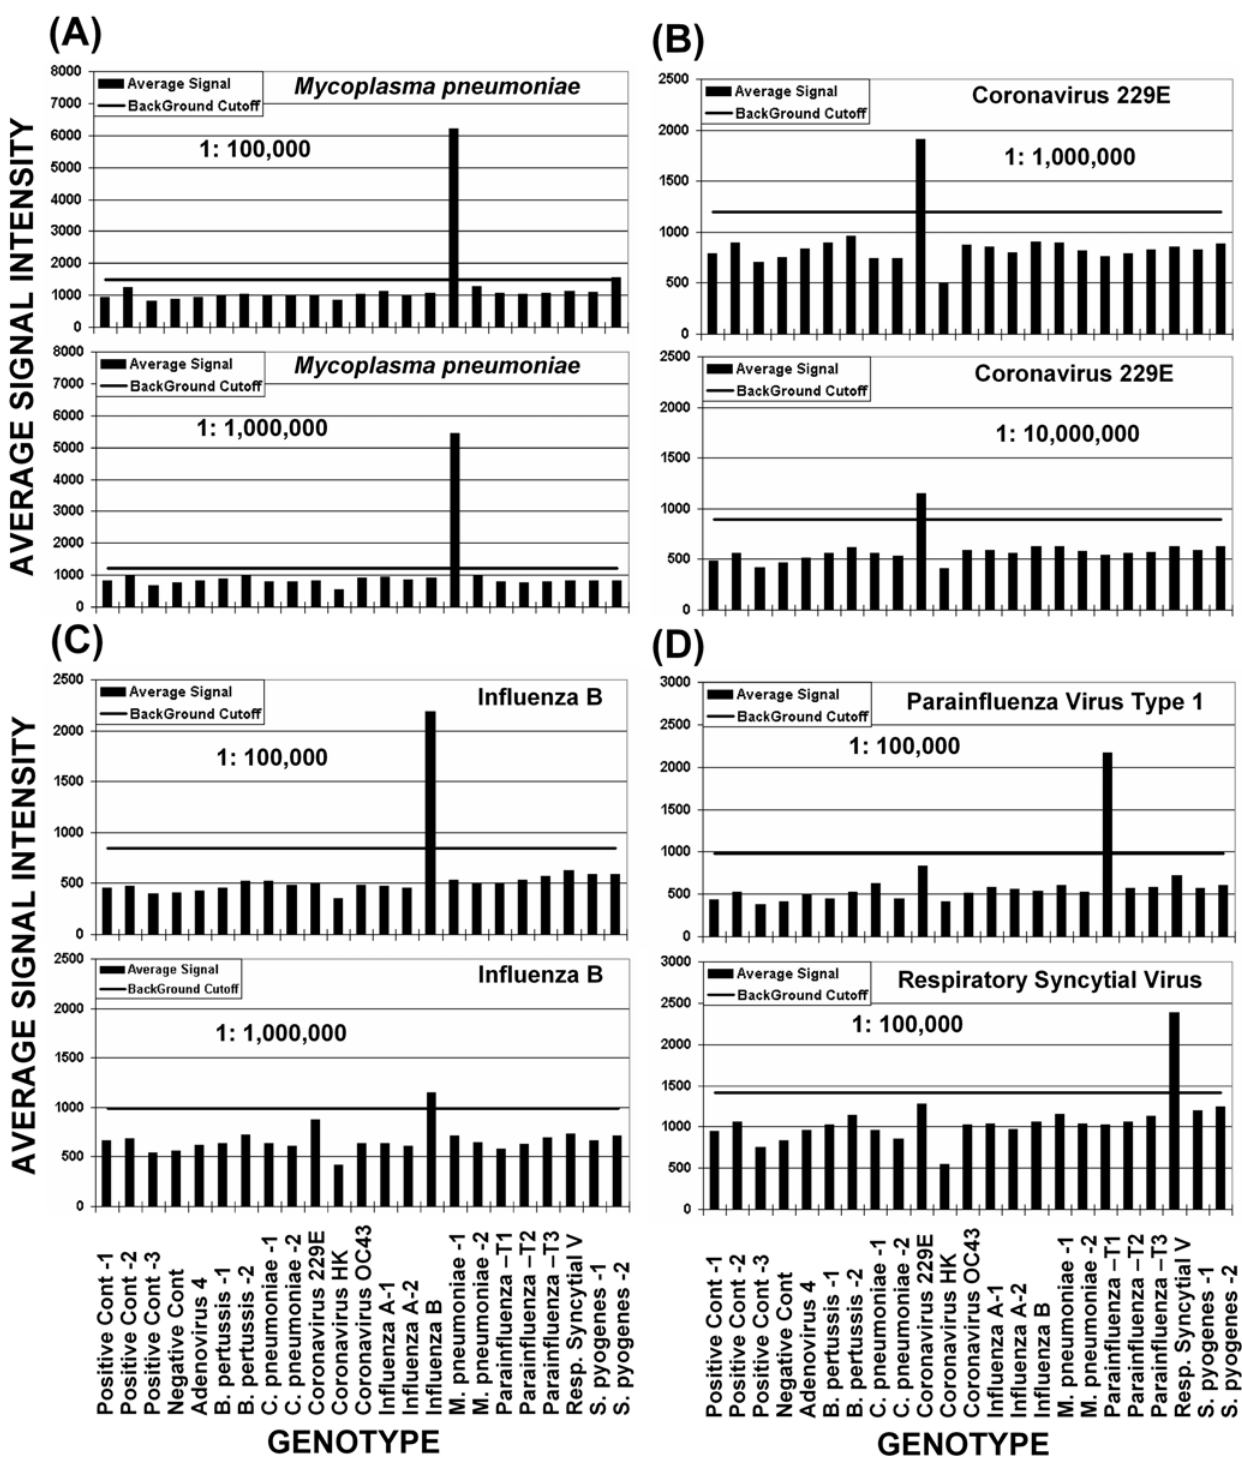
Figure 6. Results of sensitivity studies for Mycoplasmapneumoniae(A); coronavirus 229E (B); influenza B (C); and PIV 1, and RSV (D). Vertical bars indicate the mean signal intensities in picoamps for positive genotypes (above cutoff bar) and negative genotypes (below cutoff bar). Horizontal bars indicate the assay cutoff, which is based on the mean of the negative control probes, plus 3 standard deviations of the mean. Relative probe electrochemical signal intensities in picoamps are shown to the left and probe identities are shown below. The identity of the pathogen tested and the dilution factor are shown on each graph. Beginning target nucleic acid concentrations are shown in Table 2.